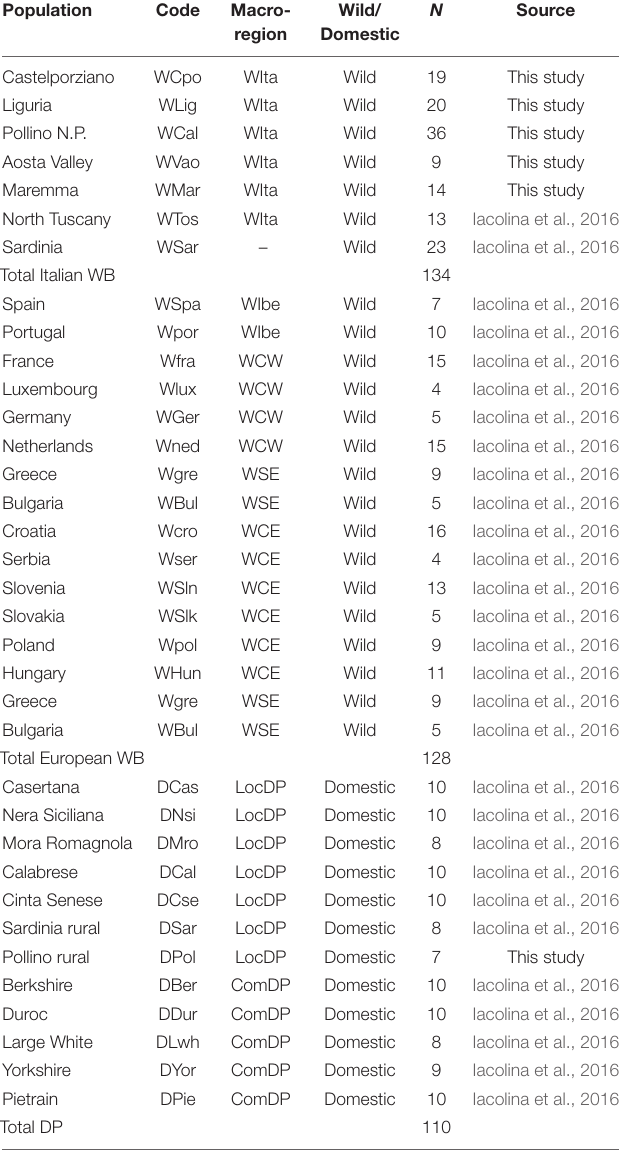
TABLE 1 | List of Italian and European wild boar (WB) and domestic pig (DP) samples used in the study. Population Code Macro-